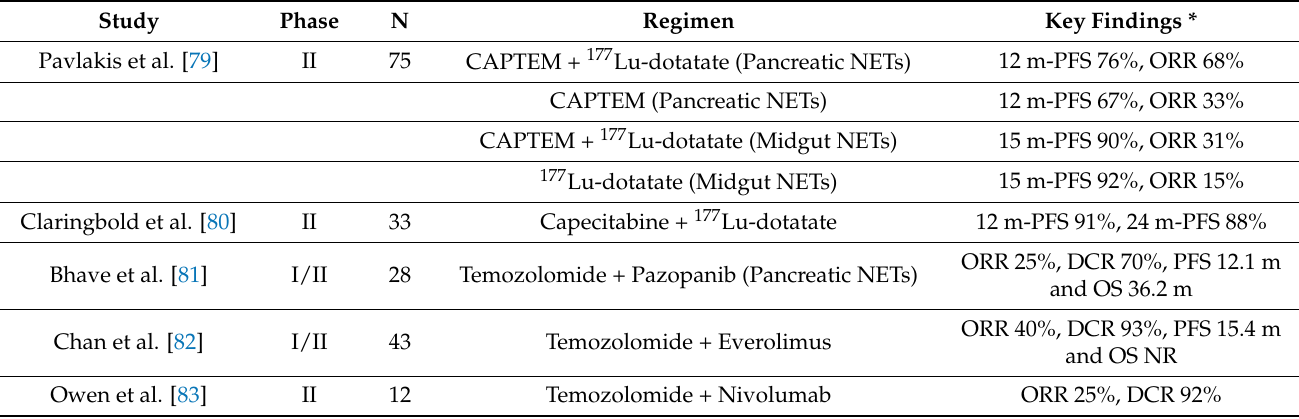
Table 3. Prospective trials combining chemotherapy with other systemic therapies in patients with NETs.